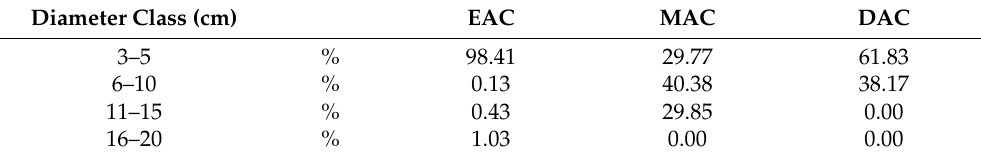
Table 2. Percentage distribution of log volume (%) by diameter class in the accessibility classes.